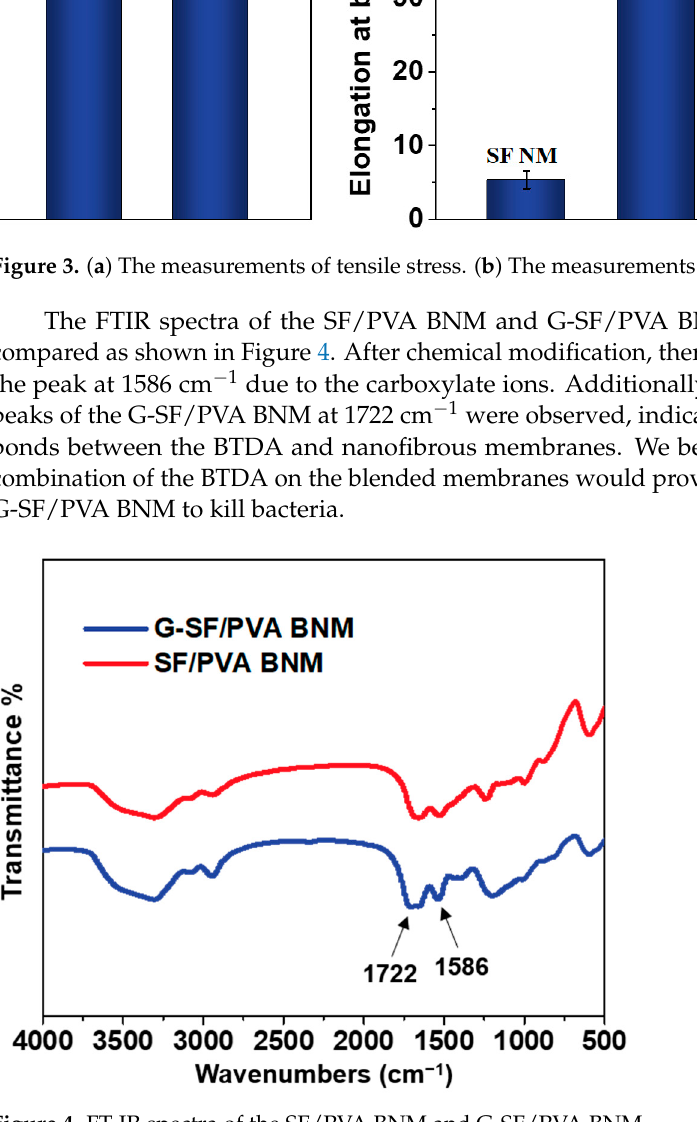
Figure 4. FT-IR spectra of the SF/PVA BNM and G-SF/PVA BNM.